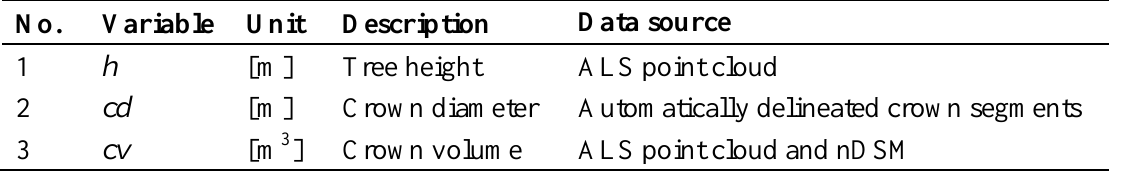
Table 5. Individual tree features derived from ALS